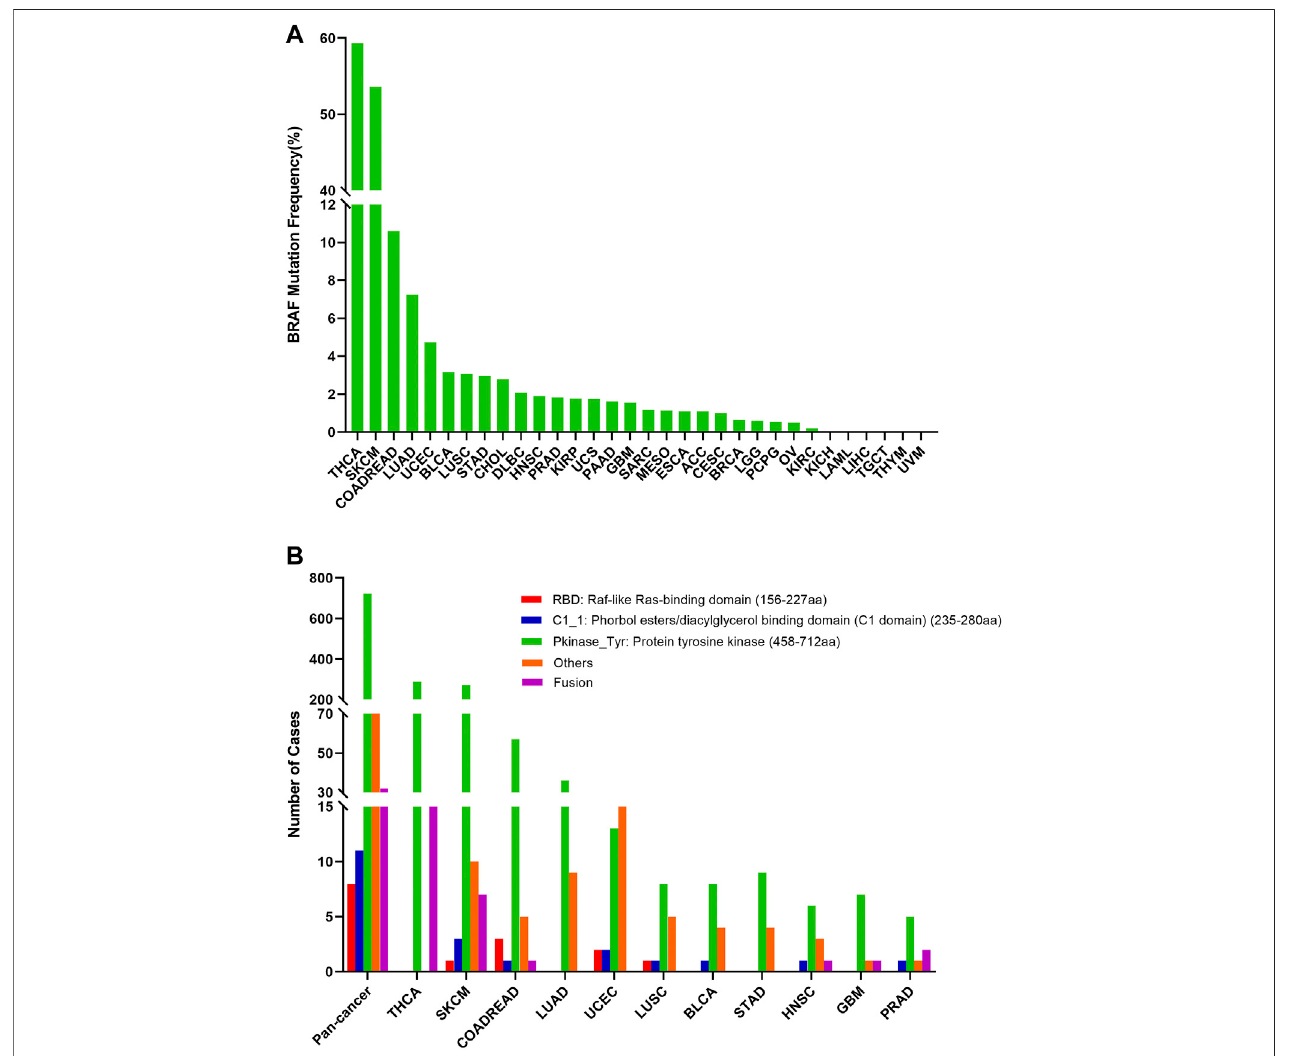
FIGURE 2 | BRAF mutation distribution in various cancer types and protein functional domains. (A) BRAF mutation frequency across 32 TCGA cancer types. (B) BRAF mutation distribution in different protein functional domains in all and top 10 tumor types. Abbreviation: aa: amino acid.